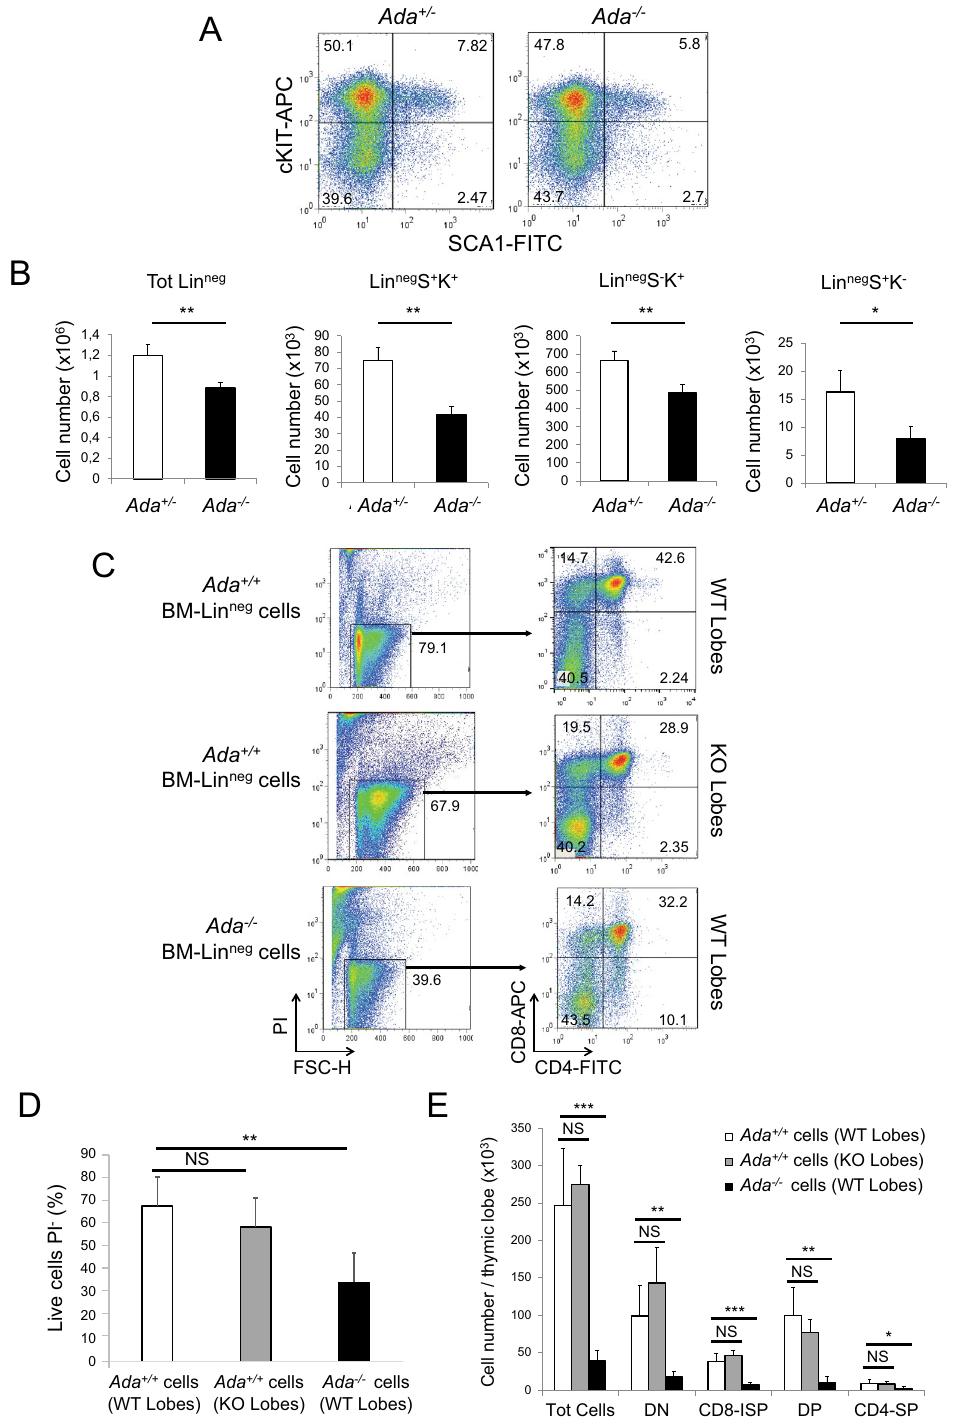
Figure 2. BM-derived HSPC populations from ADA-deficient mice show reduced cellularity and impaired development and function. ( A ) FACS plots of BM Lin neg cell populations from mice at P14: primitive hematopoietic stem cells (SCA1 + , cKIT + ), myeloid progenitor cells (SCA1 − , cKIT + ) and early lymphoid- committed precursors (SCA1 + , cKIT − ). ( B ) Bar graphs representing absolute numbers of cell populations shown in (A) per mouse (n = 4, 3). ( C ) FTOC performed coculturing thymic lobes with BM Lin neg cells for 3 weeks. FACS plots show live cells (PI negative populations) recovered from squeezed lobes (left panels) and distribution of developing thymocytes (right panels). Immature CD8-SP (CD8-ISP) (CD4 − , CD8 + ), DP (CD4 + , CD8 + ), CD4-SP (CD4 + , CD8 − ). ( D ) Bar graph representing percentage of live cells shown in (C) (n = 6, 4, 5). ( E ) Total number of cells per thymic lobe per each experiment condition (n = 6, 4, 5). * P < 0.05, ** P < 0.01 and *** P < 0.001. NS = statistically not